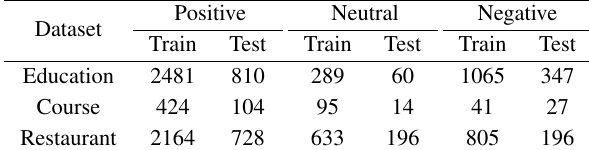
Table 1 Polarity distribution of labels in dataset